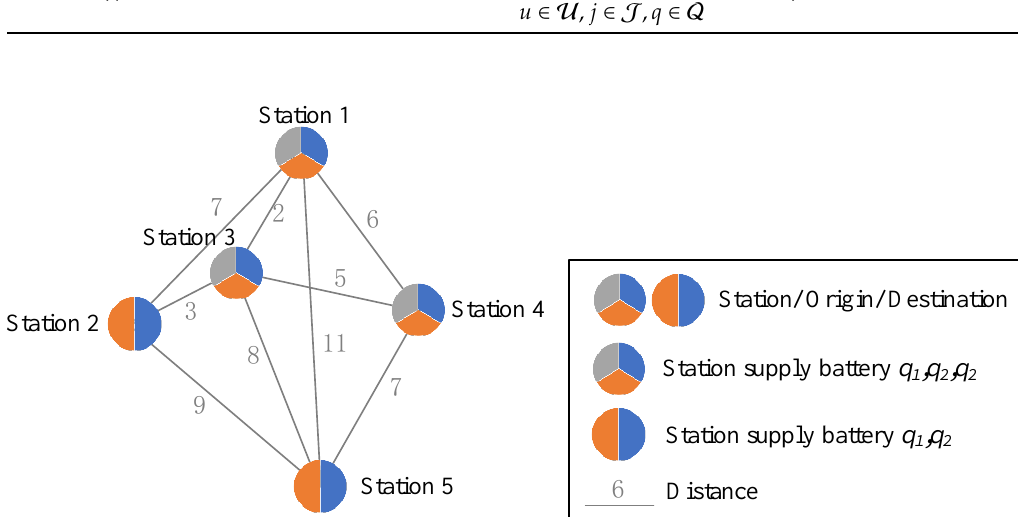
Figure 2. Example network with different battery mode supplies in the SSC station.